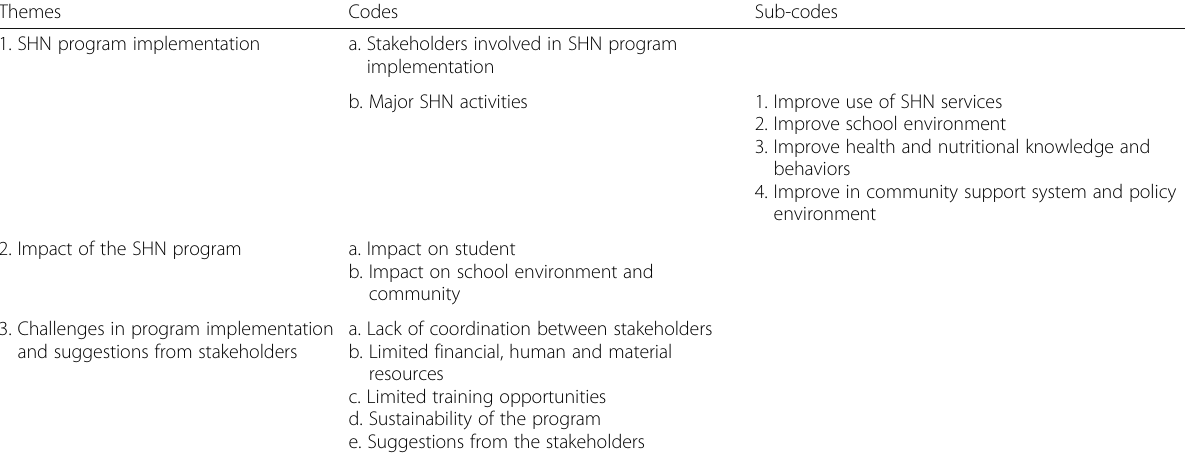
Table 2 Themes, codes, and sub-codes used for data analysis